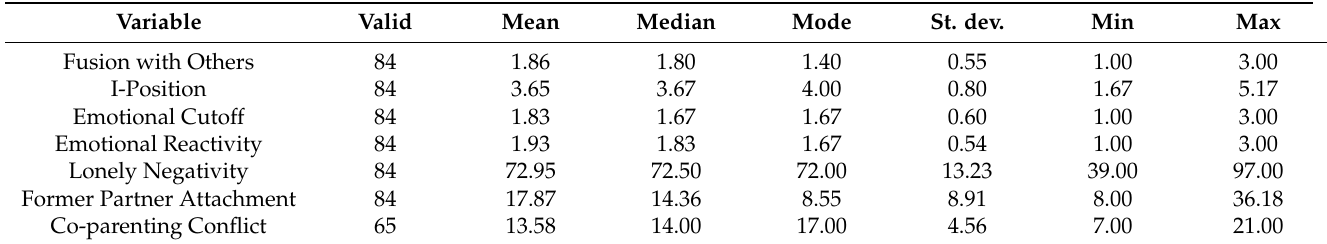
Table 2. Summary statistics for differentiation of self-inventory–short form and psychological adjustment to separation test scales.